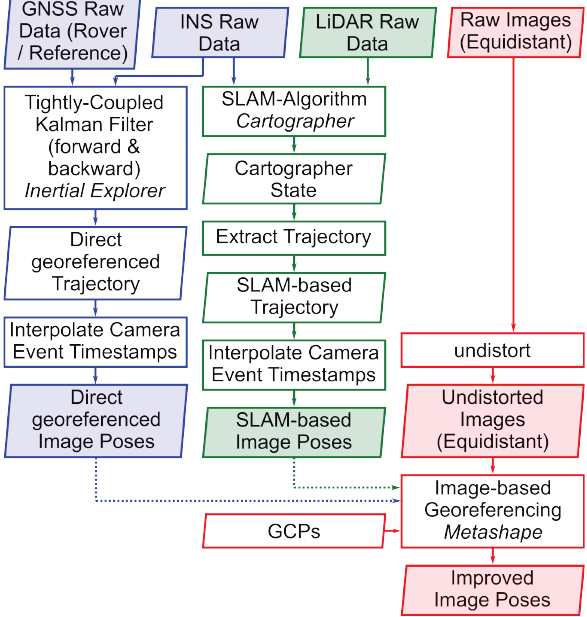
Figure 2. Extended flow chart indicating our data post-process- Figure 1. BIMAGE Backpack sensor configuration for indoor ing workflow (Blaser et al., 2018). The blue elements belong and outdoor applications. Sensors marked with blue lines are mainly used for direct georeferencing, green lines show sensors used for LiDAR-SLAM-based georeferencing and red lines components for image-based georeferencing. Black lines repre- sent supporting components.